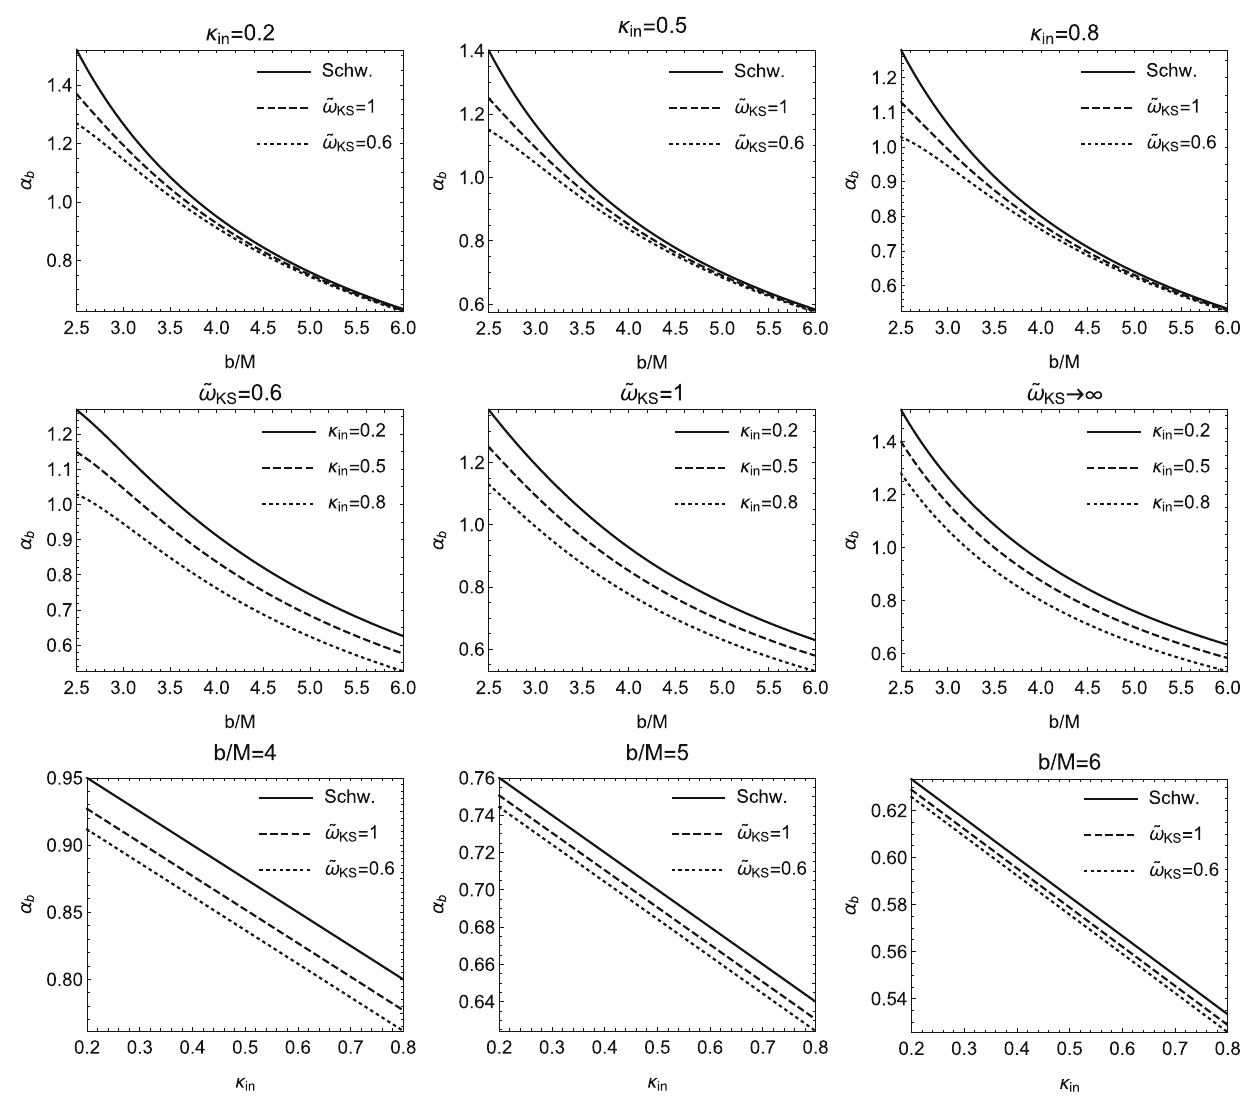
of the deflection angle of photon with plasma parameter for various combinations of dimensionless “Hoˇrava parameter” ( ˜ ω